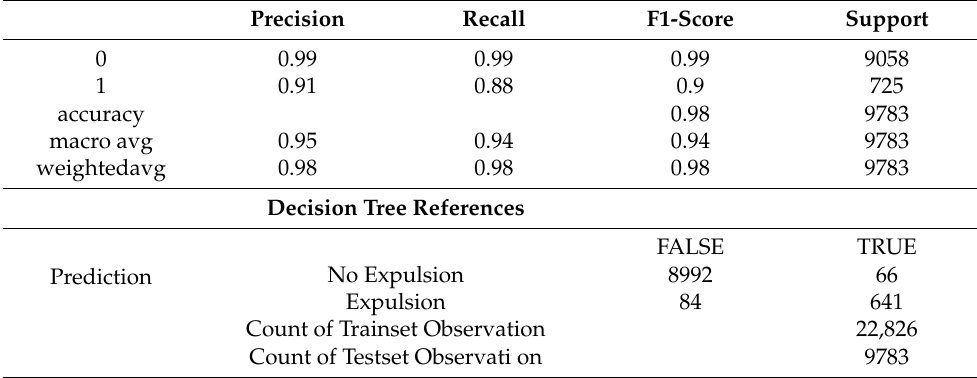
Table 12. Confusion matrix for decision